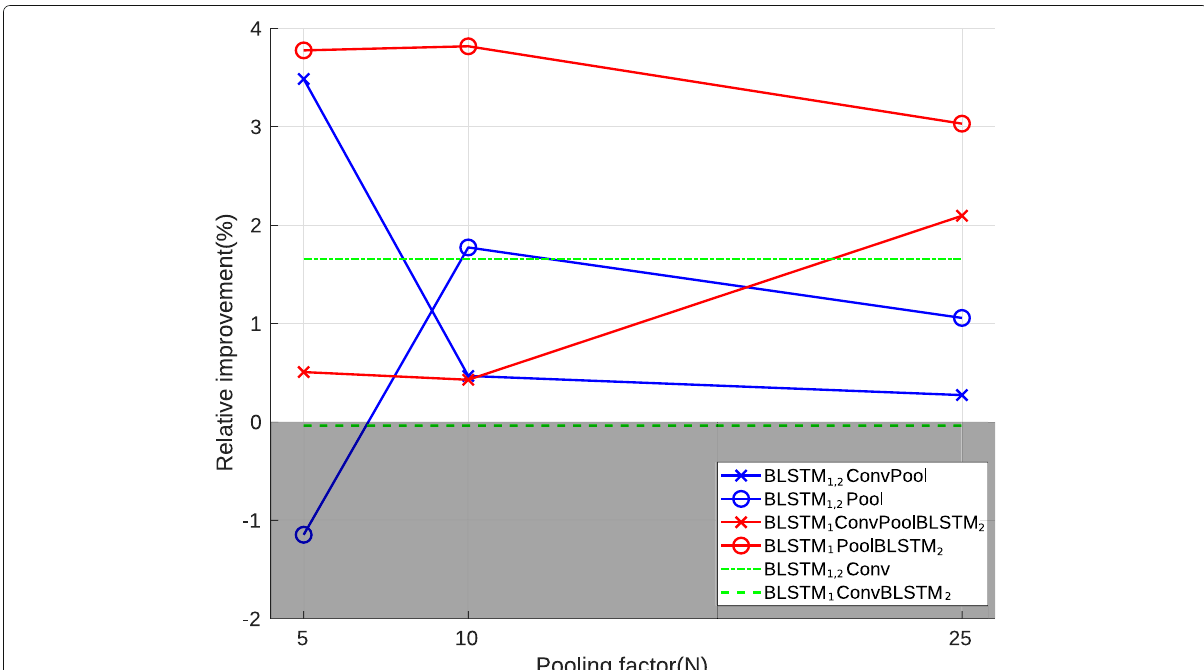
Fig. 5 Relative improvement over the baseline RNN classifier for the setup using the combination and pool block between both BLSTM layers and the setup using the combination and pooling block after the last BLSTM layer